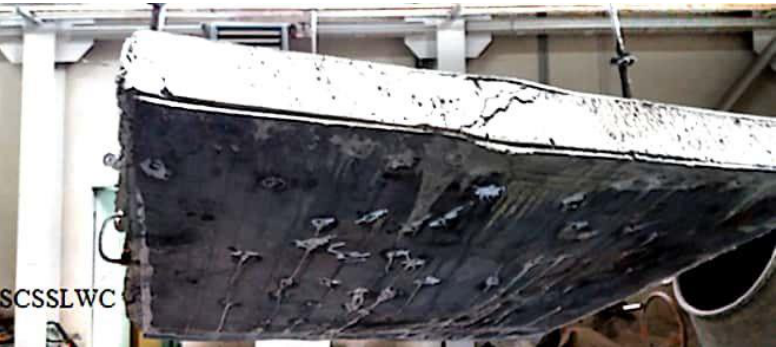
Figure 11. Deformation of the bottom and top plate. Appl. Sci. 2020 , 10 , x